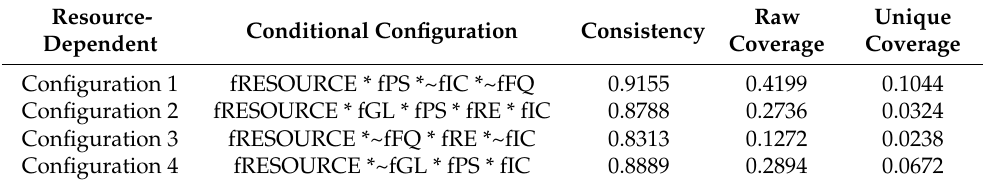
Table 5. Conditions of application of resource-dependent